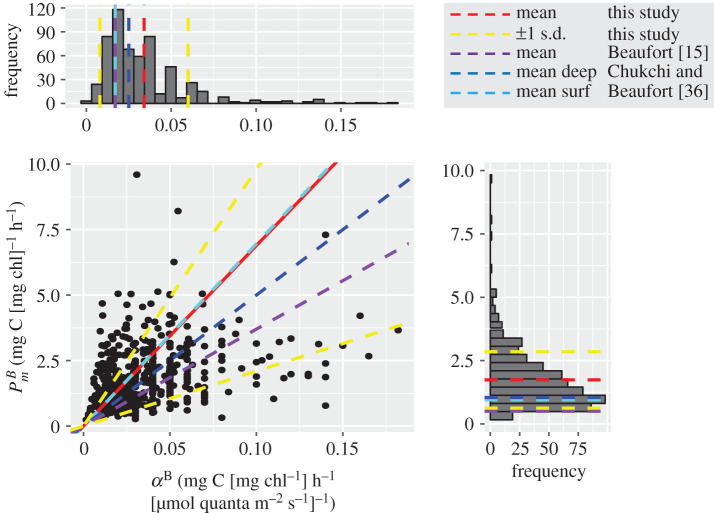
Correlation between the two PE parameters, the assimilation number (PmB) and the initial slope (αB), and their corresponding frequency distributions for the Arctic dataset used in this study. Red lines indicate mean parameter values for this study, blue and cyan dashed lines represent deep and surface assemblages in the Chukchi and Beaufort Seas [36], and purple dashed all samples from the Beaufort Sea [15]. Yellow lines represent ±1 s.d. from the mean value for this study.